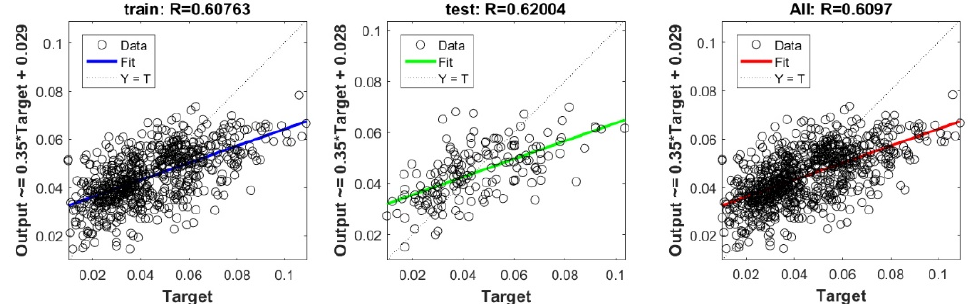
Figure A2. Scatter plots between target and output value by the FS-DNN model.